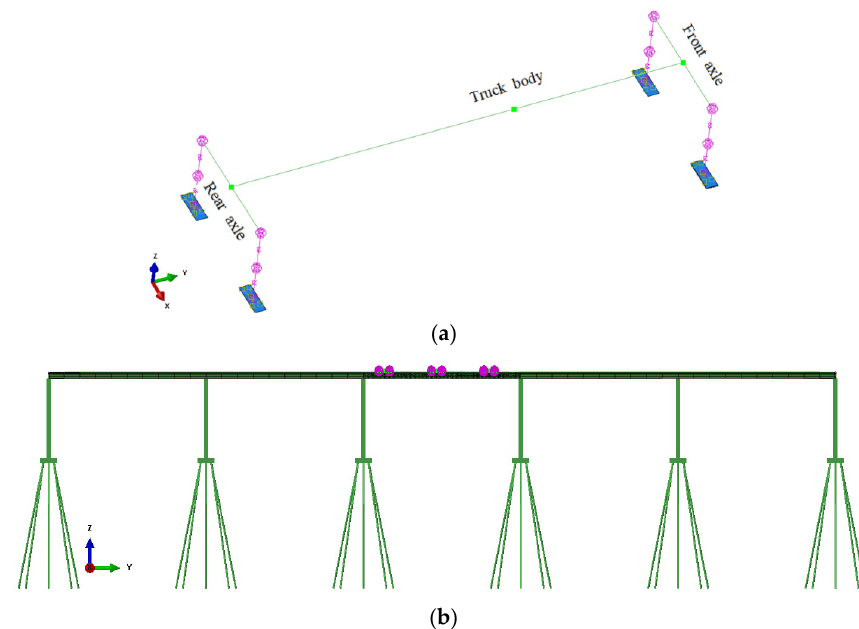
Figure 8. Finite element model of vehicle–bridge coupling system in ABAQUS. ( a ) Truck model, ( b ) vehicle–bridge interaction model.